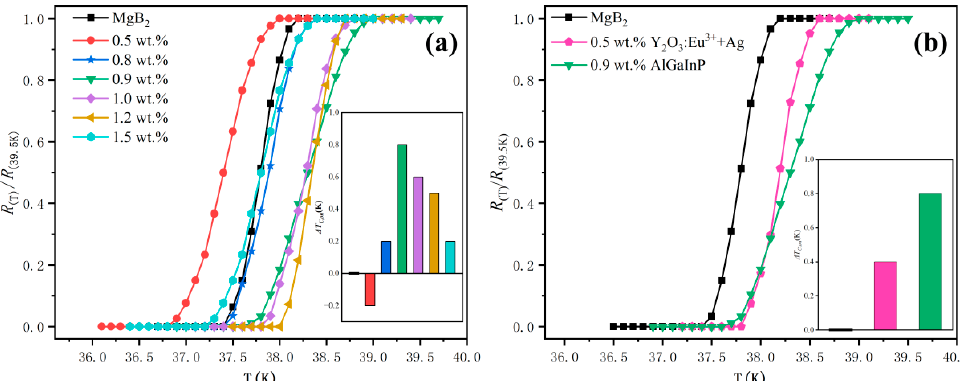
Figure 5. R-T curve of MgB 2 sample. ( a ) Doping results of pure MgB 2 and inhomogeneous phase at different concentrations, Insets: the values of Δ T C ( Δ T c = T c − T cpure ). ( b ) Comparison of the maximum variation of ∆ T C produced by pure MgB 2 and oxide electroluminescence inhomogeneous phase [46], p-n junction inhomogeneous phase.